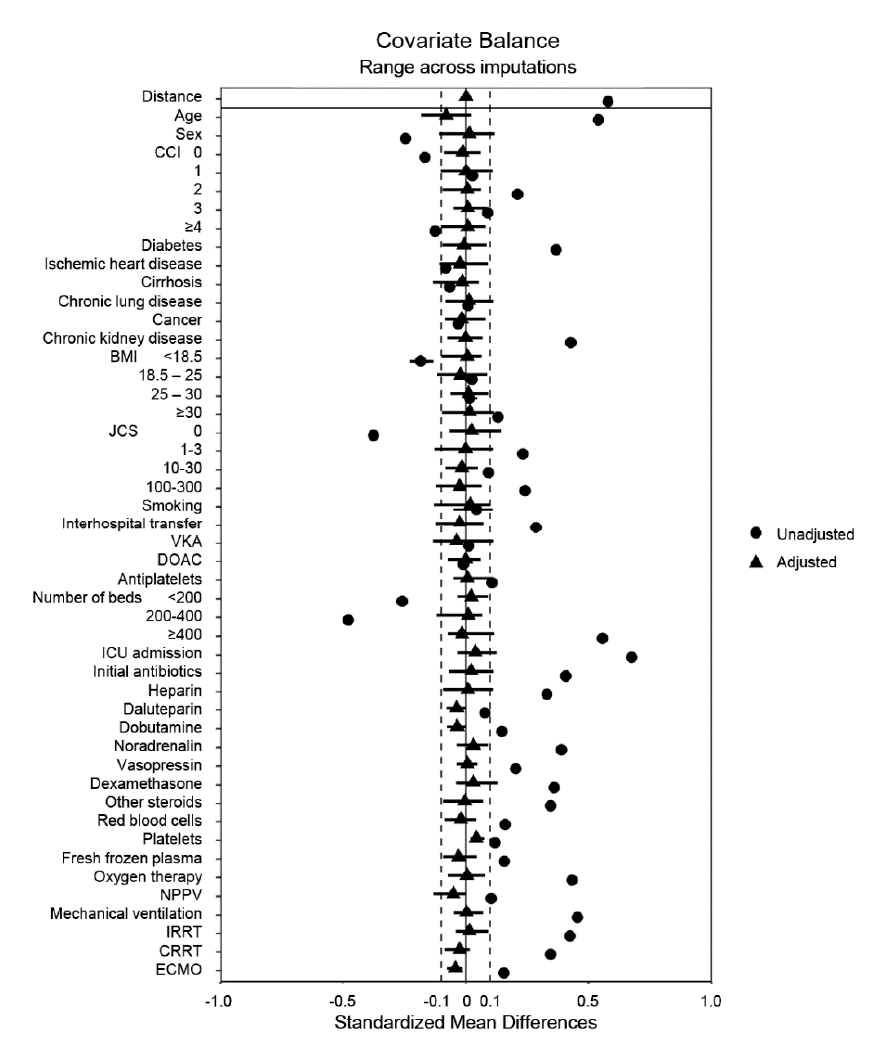
Figure 2. A summary plot of covariate balance before and after matching. BMI, body mass index; CCI, Charlson comorbidity index; CRRT, continuous renal replacement therapy; DOAC, direct oral anticoagulant; ECMO, extracorporeal membrane oxygenation; ICU, intensive care unit; IRRT, intermittent renal replacement therapy; JCS, Japan Coma Scale; NPPV, noninvasive positive-pressure ventilation; VKA, vitamin K antagonist.